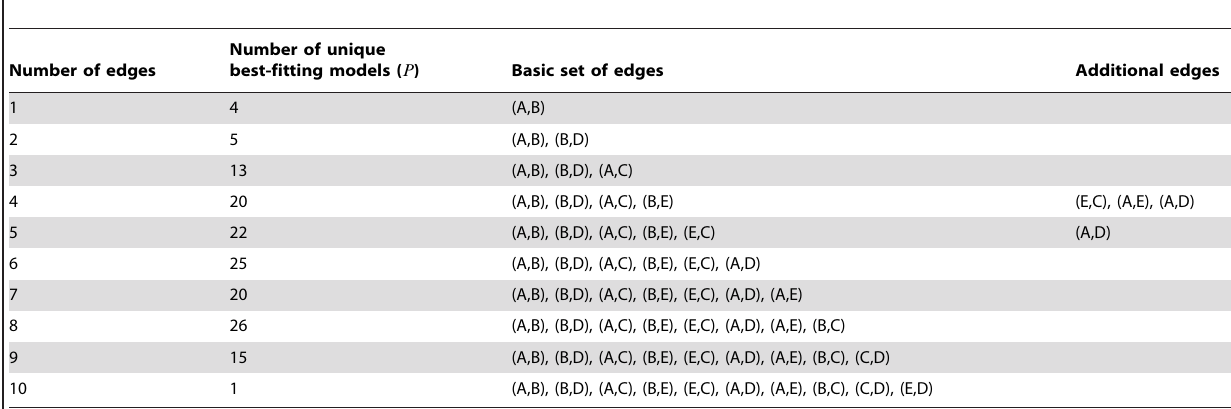
Table 4. Edges present in the best-fitting models in human (BIC